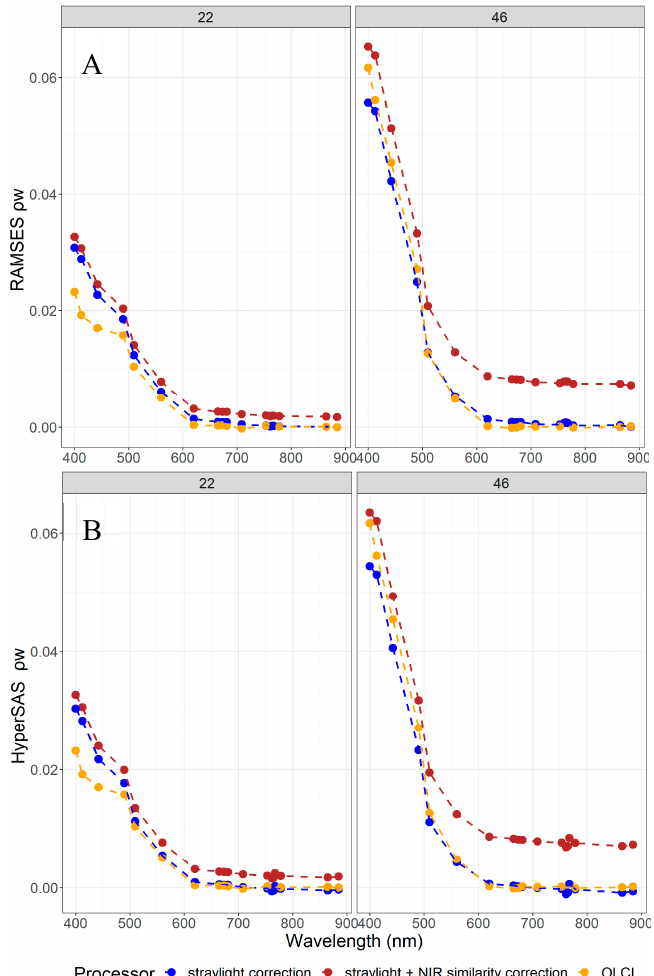
Figure 18. Correlation between OLCI-to-RAMSES ( A ) and OLCI-to-HyperSAS ( B ) water-leaving reflectances at selected wavelengths.